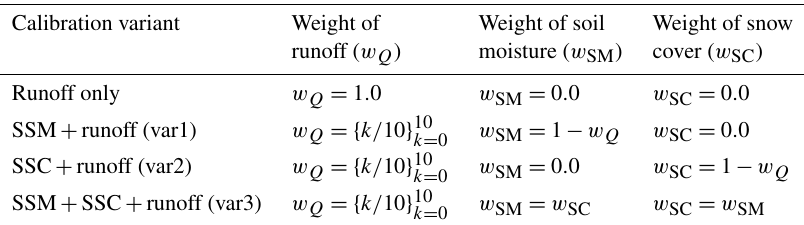
Table 3. Weights given to runoff, satellite soil moisture (SSM), and satellite snow cover (SSC) in the multiple objective calibration (Eq. 1) for different calibration variants. A set of 11 w Q weights in the range 0.0 and 1.0 is tested for each multiple objective calibration variant. The sum of weights is always